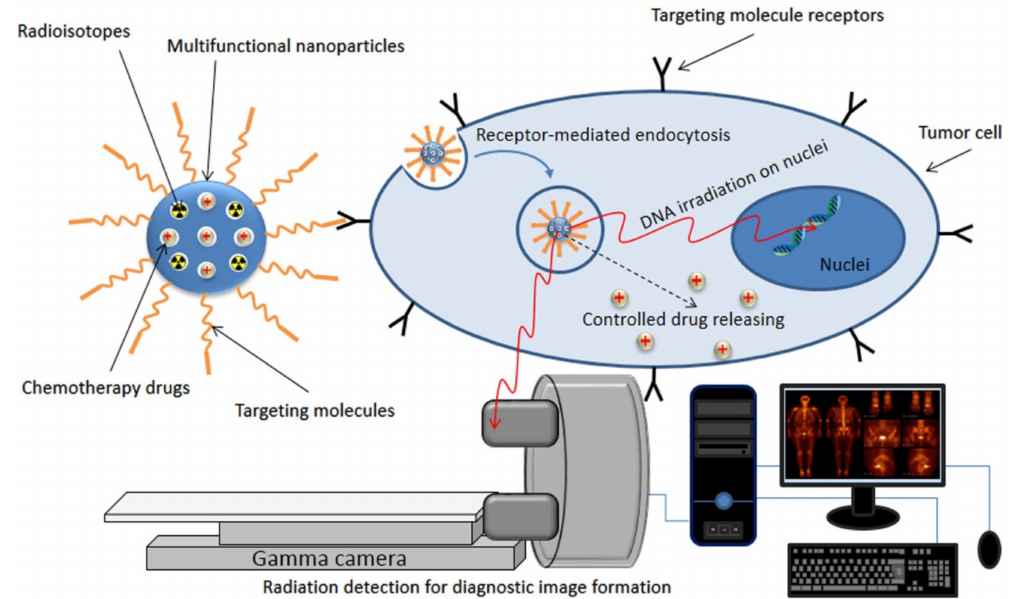
Figure 13. Scheme of a theranostic system. Image reproduced with permission from